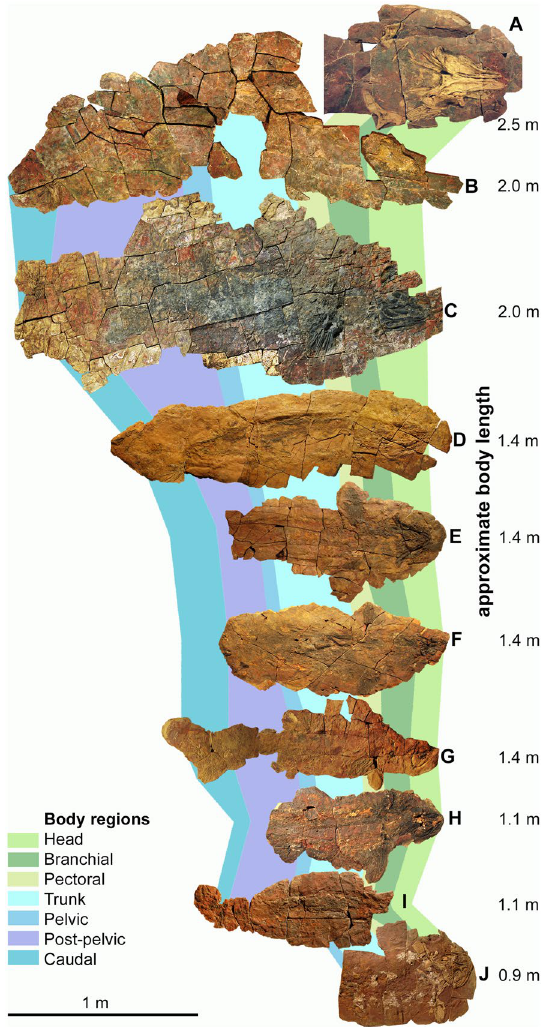
Fig. 1 Skeletons of Maghriboselache mohamezanei n. gen. et sp. Famennian, eastern Anti-Atlas (for locality details, see supplement). Homologous body regions are indicated by colored fields. Only J is from the southern Tafilalt, all others are from the southern Maïder region. A PIMUZ A/I 5152; B AA.MEM.DS.12; C , AA.MEM.DS.6; D PIMUZ A/I 5153; E PIMUZ A/I 5154; F PIMUZ A/I 5155; G AA.BER.DS.01; H PIMUZ A/I 5156; I PIMUZ A/I 5157; J PIMUZ A/I